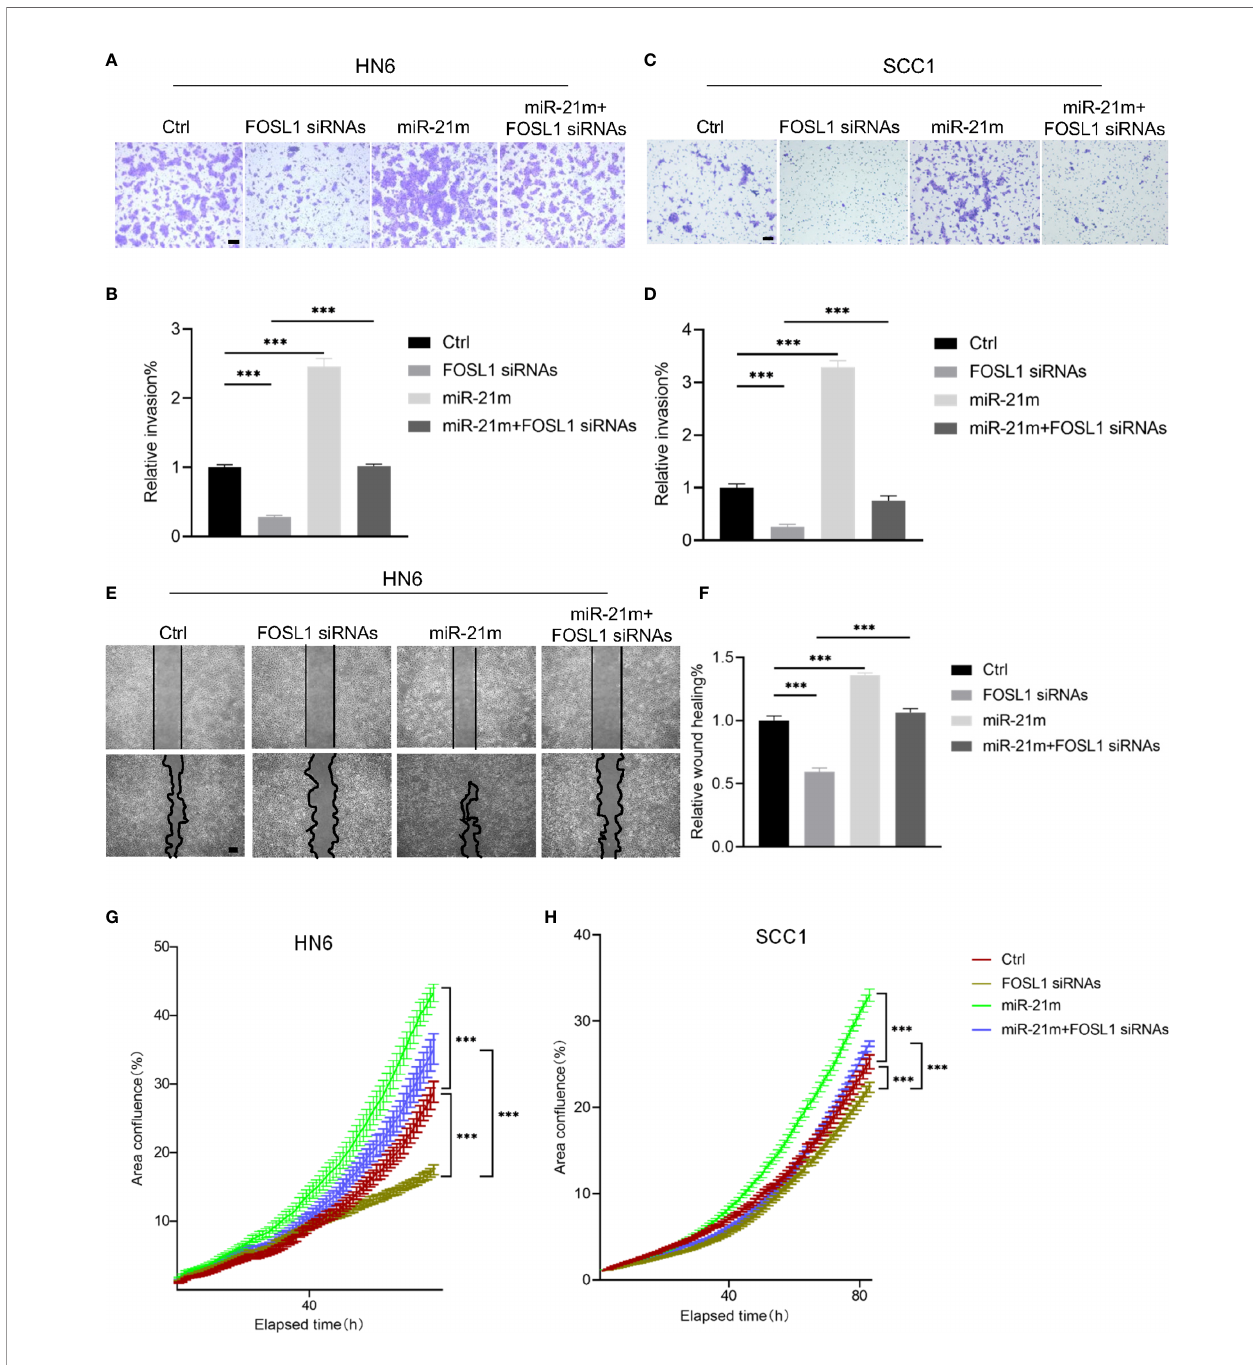
FIGURE 3 | miR-21-5p was required for FOSL1-medaited malignant progression in HNSCC. (A-D) FOSL1 depletion-mediated inhibition of cell invasion was attenuated by overexpressing miR-21-5p in SCC1 and HN6 cells. ***P < 0.001 by one-way ANOVA. Scale bar, 200 m m (E, F) FOSL1 depletion-mediated inhibition of cell migration was rescued by overexpressing miR-21-5p in HN6 cells. ***P < 0.001 by one-way ANOVA. Scale bar, 200 m m (G, H) FOSL1 depletion-mediated inhibition of cell proliferation was impaired by overexpressing miR-21-5p in SCC1 and HN6 cells. ***P < 0.001 by two-way